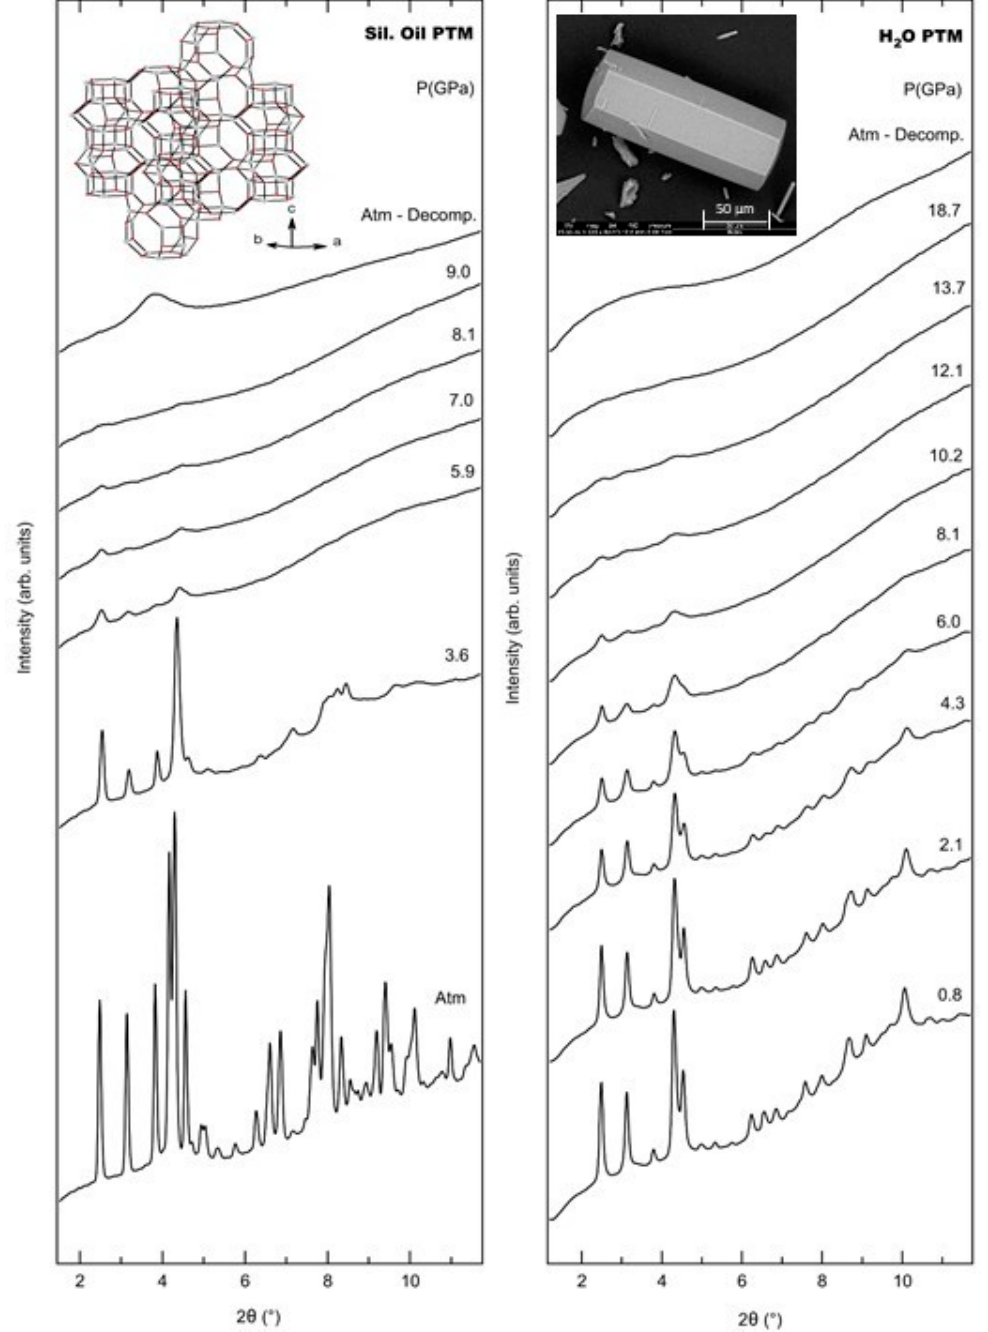
Figure 1. In situ powder synchrotron X-ray diffraction XRD patterns of AlPO 4 -17• x H 2 O in silicone oil ( left ) and in H 2 O ( right ) at selected pressures. Insert: Scanning Electron Microscope image of the as-synthesized hydrated AlPO 4 -17 ( right ) and 3D framework structure of AlPO 4 -17 (reproduced from Ref. [16]) showing the columns of alternating cancrinite cages connected along the c direction by hexagonal prisms forming the t-eri pore structural unit ( left ).